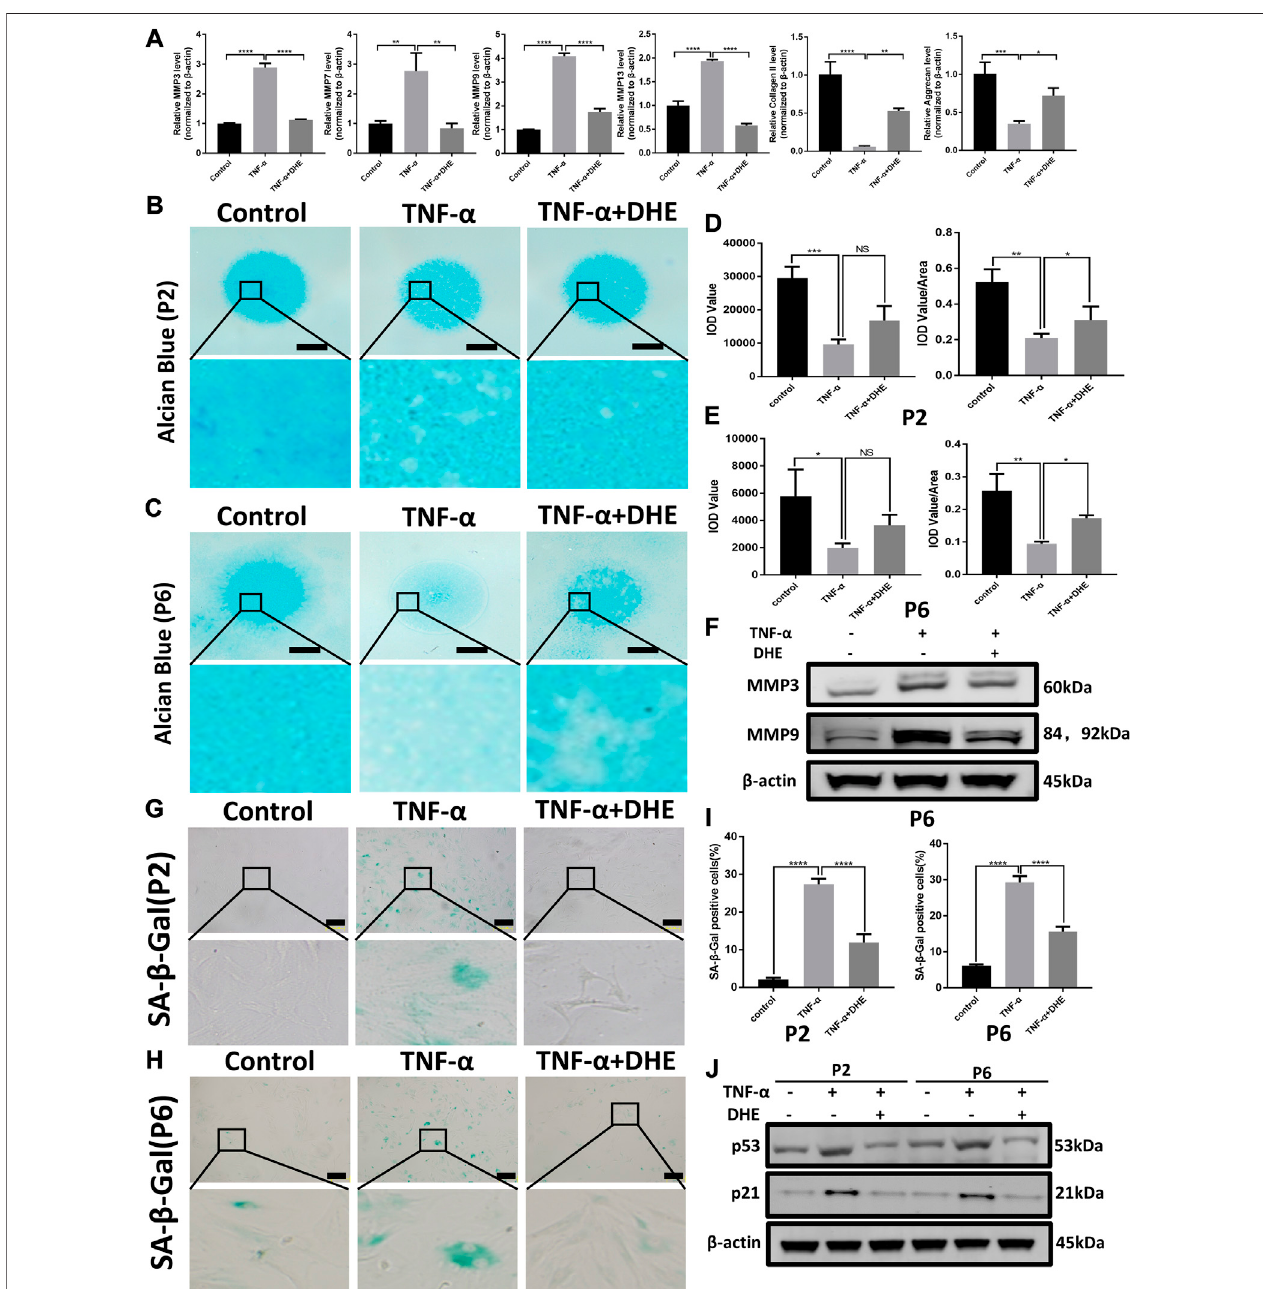
FIGURE 2 | Dehydrocostus lactone (DHE) alleviated tumor necrosis factor- α (TNF- α ) – induced extracellular matrix (ECM) degradation and ameliorated TNF- α – inducedsenescenceofnucleuspulposus(NP)cells (A) Thequantitativereal-timepolymerasechainreaction(RT-qPCR)wasperformedtodetecttheexpressionofthe anabolism and catabolism genes containing matrix metalloproteins (MMPs) 3, 7, 9, and 13; collagen II; and aggrecan after treatment with TNF- α (20 ng/ml) with or without DHE (2.5 μ M) for 24 h. The expression of these genes was normalized to the expression of β -actin. n (cid:2) 3. Data are presented as the mean ± SEM of three independentexperiments.* p < 0.05,** p < 0.01,*** p < 0.001and**** p < 0.0001relativetotheTNF- α – inducedgroup (B,C) AlcianblueshowedthestainingofNPprimary cells(P2generation;B)and (P6generation;C)onhigh-density cultureafter treatment withTNF- α (20 ng/ml)orTNF- α (20 ng/ml)and DHE(2.5 μ M)for9 days.Scalebar, 2 mm (D,E) The integrated optical density (IOD) value and IOD value/area calculations were performed to evaluate the extracellular matrix (ECM) of NP primary cells (P2 and P6) after the indicated treatment. Data are presented as the mean ± SEM of three independent experiments. * p < 0.05, ** p < 0.01, and *** p < 0.001 relative to the TNF- α – induced group (F) Western blots demonstrated the effects of DHE on MMP3 and MMP9 expression induced by TNF- α (G,H) SA- β -Gal staining showed the senescenceofNPprimarycells(P2generation;G)and(P6generation;H)afterindicatedtreatmentfor3 days.Scalebar,10 μ m (I) ThestatisticsofSA- β -Gal – positiveNP primarycellsshownin Figures2G,H .Dataarepresentedasthemean ± SEMofthreeindependentexperiments.**** p < 0.0001relativetotheTNF- α – inducedgroup. (J) Western blots demonstrated the mitigating effects of DHE on the expression of the senescence indicators p21 and p53 induced by TNF- α in P2 and P6 generations of NP primary